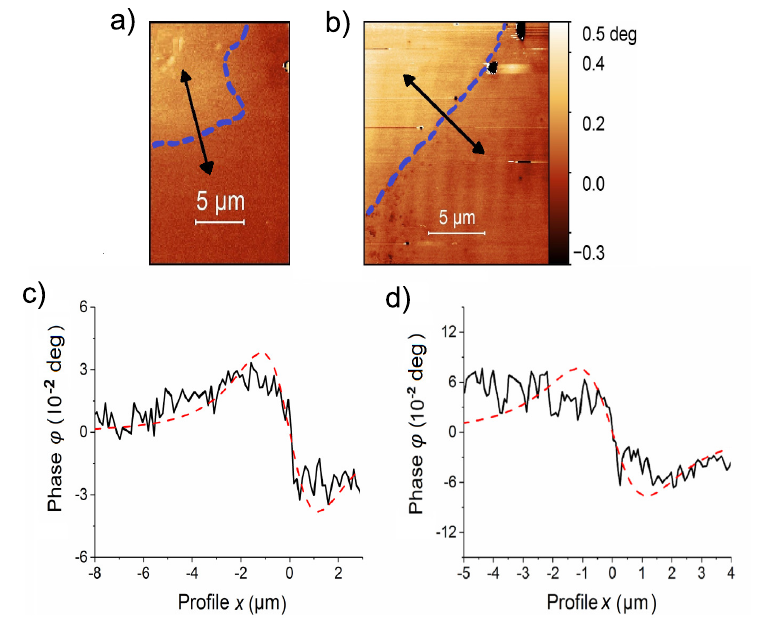
Figure 4. Phase images at the same position of the sample in remanent state (zero applied field) after applying magnetic fields of 500 Oe ( a ) and 1.5 kOe ( b ). Figures ( c , d ) show the corresponding profile lines. The dashed red lines are fitting curves. The fitting was performed according to the monopole tip approximation with the constant A = ( 24 ± 1 ) × 10 − 19 CA for ( c ) and ( 11.9 ± 0.5 ) × 10 − 17 CA for ( d